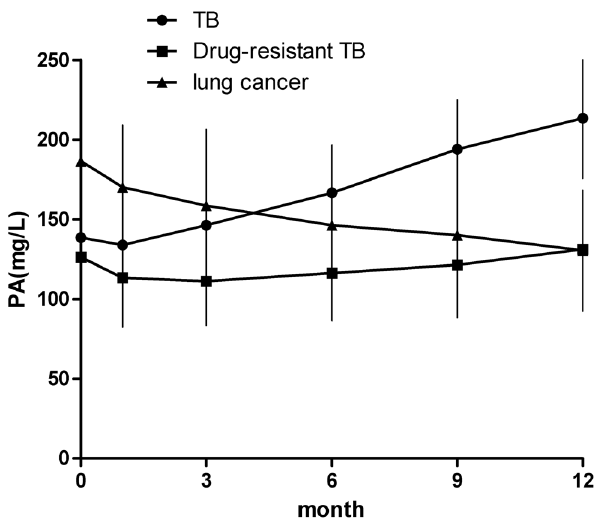
Figure S1 The flow chart of the study. Patients met a number of criterias were chosen into our study.